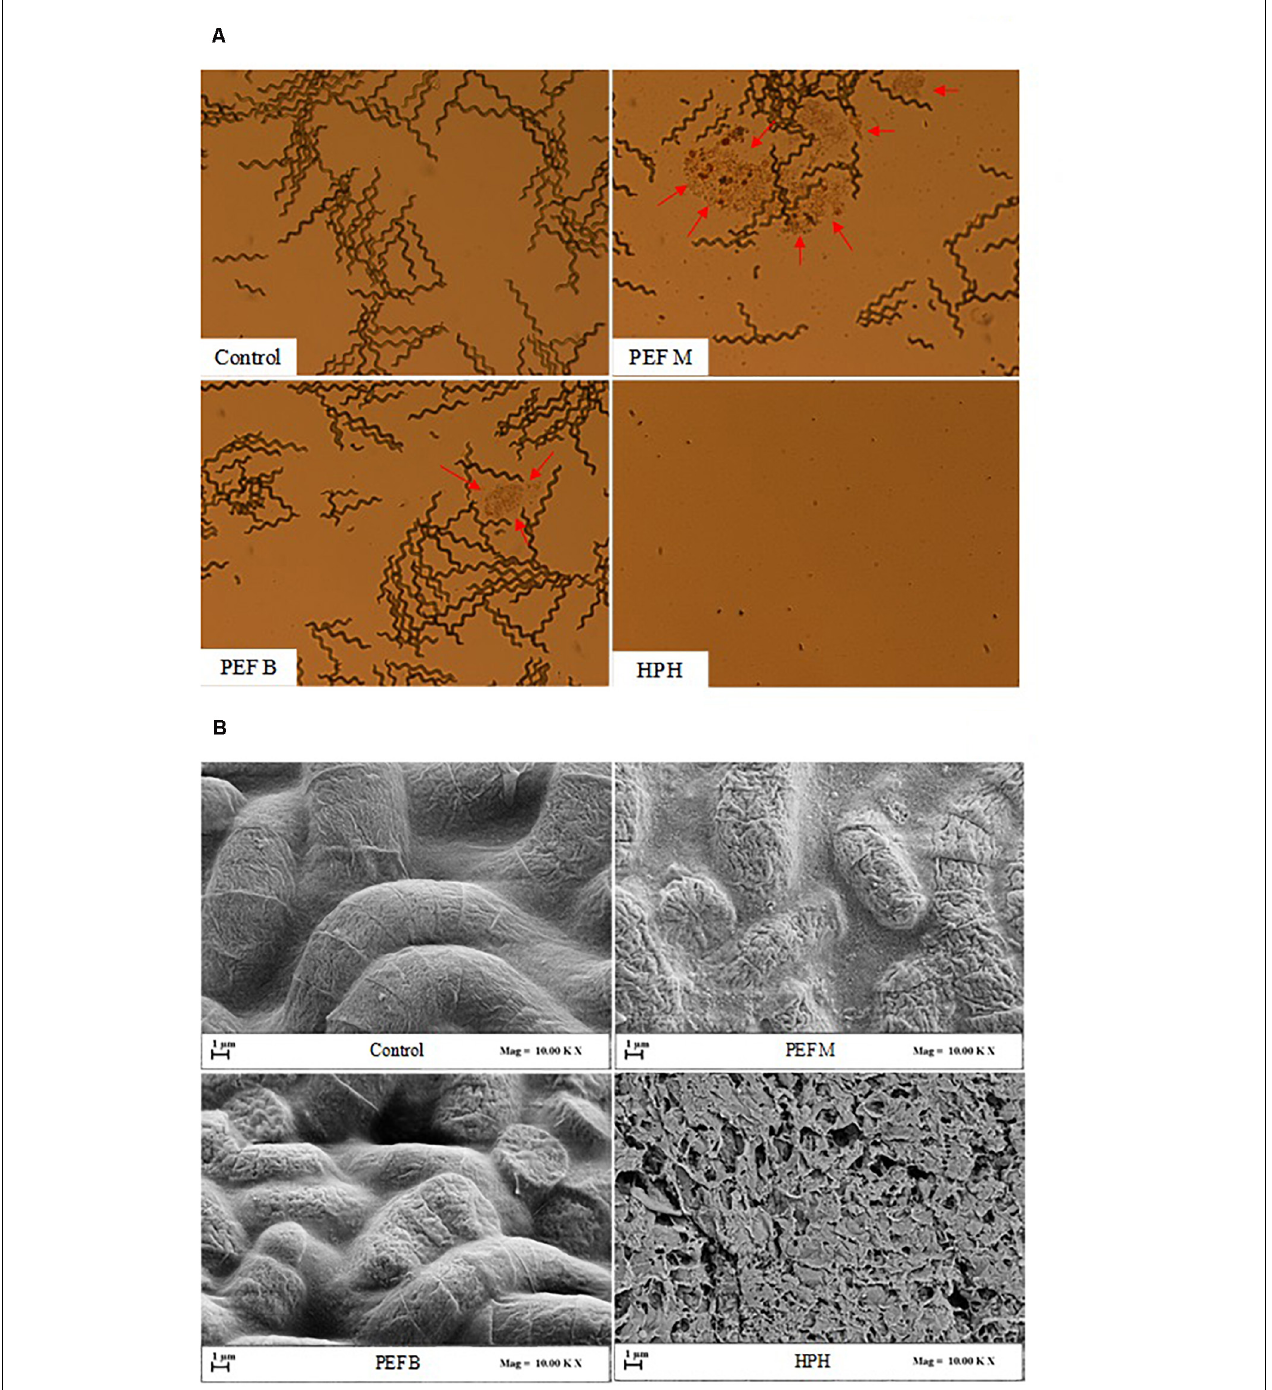
FIGURE 4 | Optical microscopy (20 × magnification) (A) and scanning electron microscopy (SEM) (B) of A. platensis cells, before (Control) and after PEF ( E = 20 kV/cm; W T = 100 kJ/kg susp ; T IN = 25 ◦ C) using either monopolar (PEF M) or bipolar (PEF B) pulses, and HPH ( P = 150 MPa; n P = 3) treatment. Red arrows indicate release of intracellular